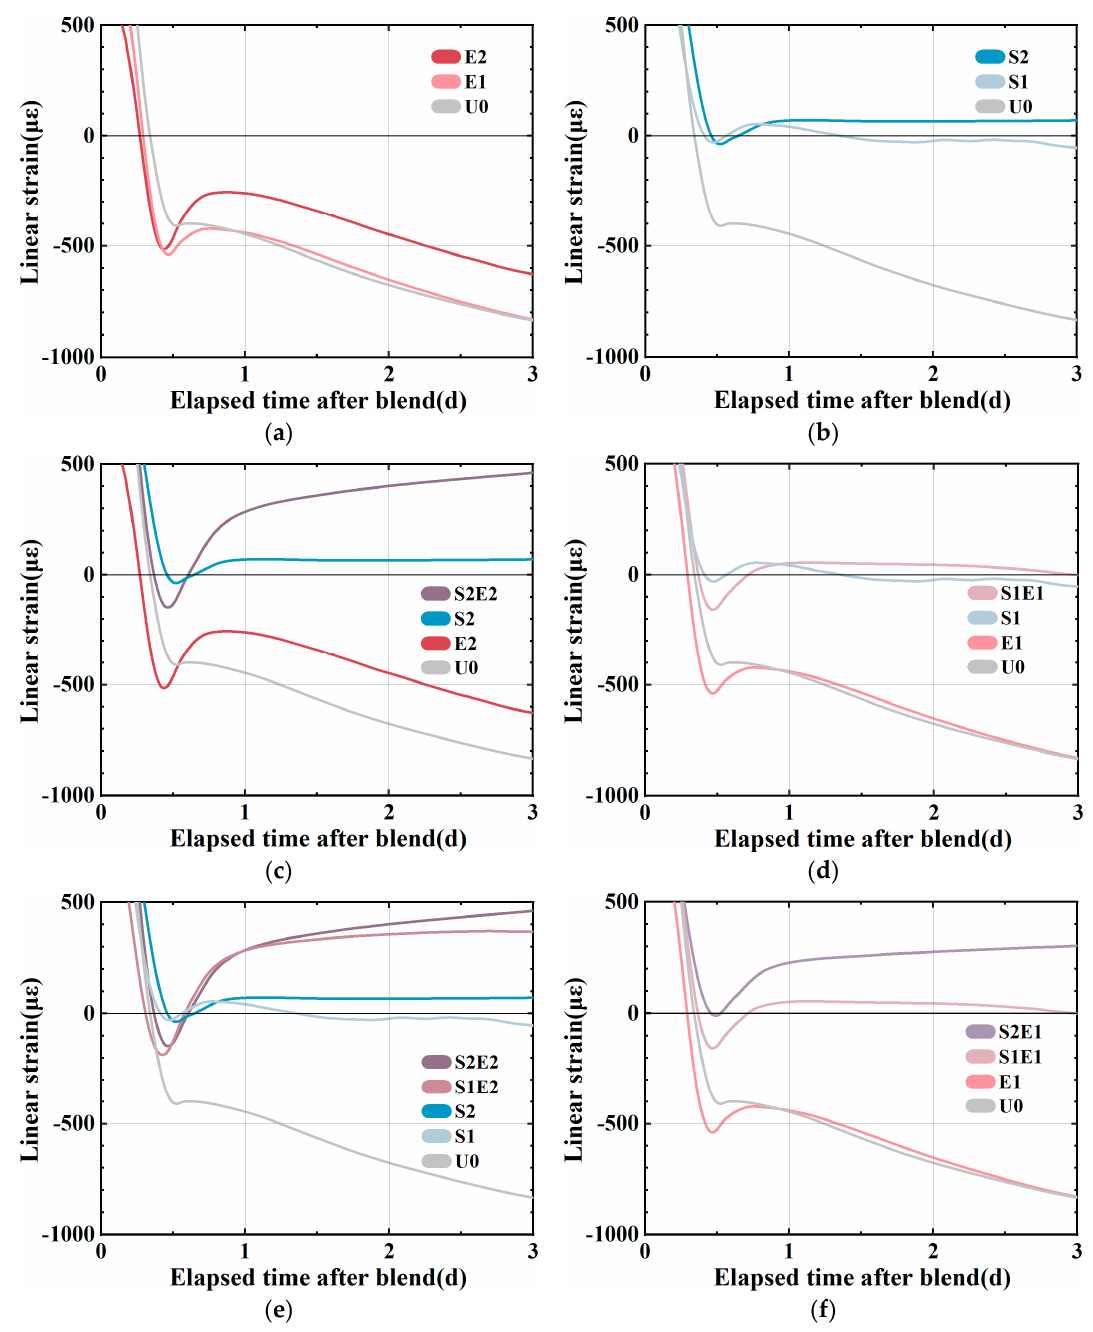
Figure 4. Autogenous shrinkage of the UHPC matrix before 3d (final setting time, 3d). ( a ) Defor- mation of matrix with CEA. ( b ) Deformation of matrix with SAP. ( c ) Deformation of S2E2. ( d ) De- formation of S1E1. ( e ) Effects of CEA in curing systems. ( f ) Effects of curing water in matrix with CEA.